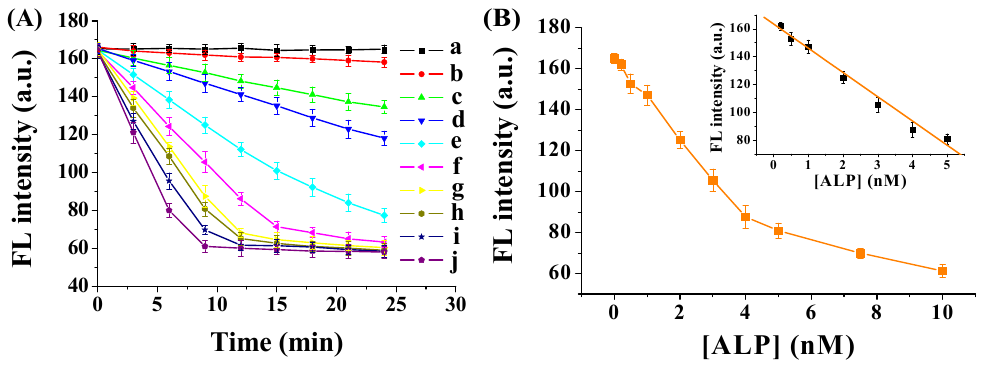
Figure 4. ( A ) Fluorescence intensity of FITC–GGGYpR/GO after addition of different concentrations of ALP (from a to j: 0, 0.2, 0.5, 1, 2, 3, 4, 5, 7.5 and 10 nM). The final concentrations of GO and FITC–GGGYpR are 50 μ g·mL − 1 and 100 nM, respectively; ( B ) Dependence of fluorescence intensity on the ALP concentration.